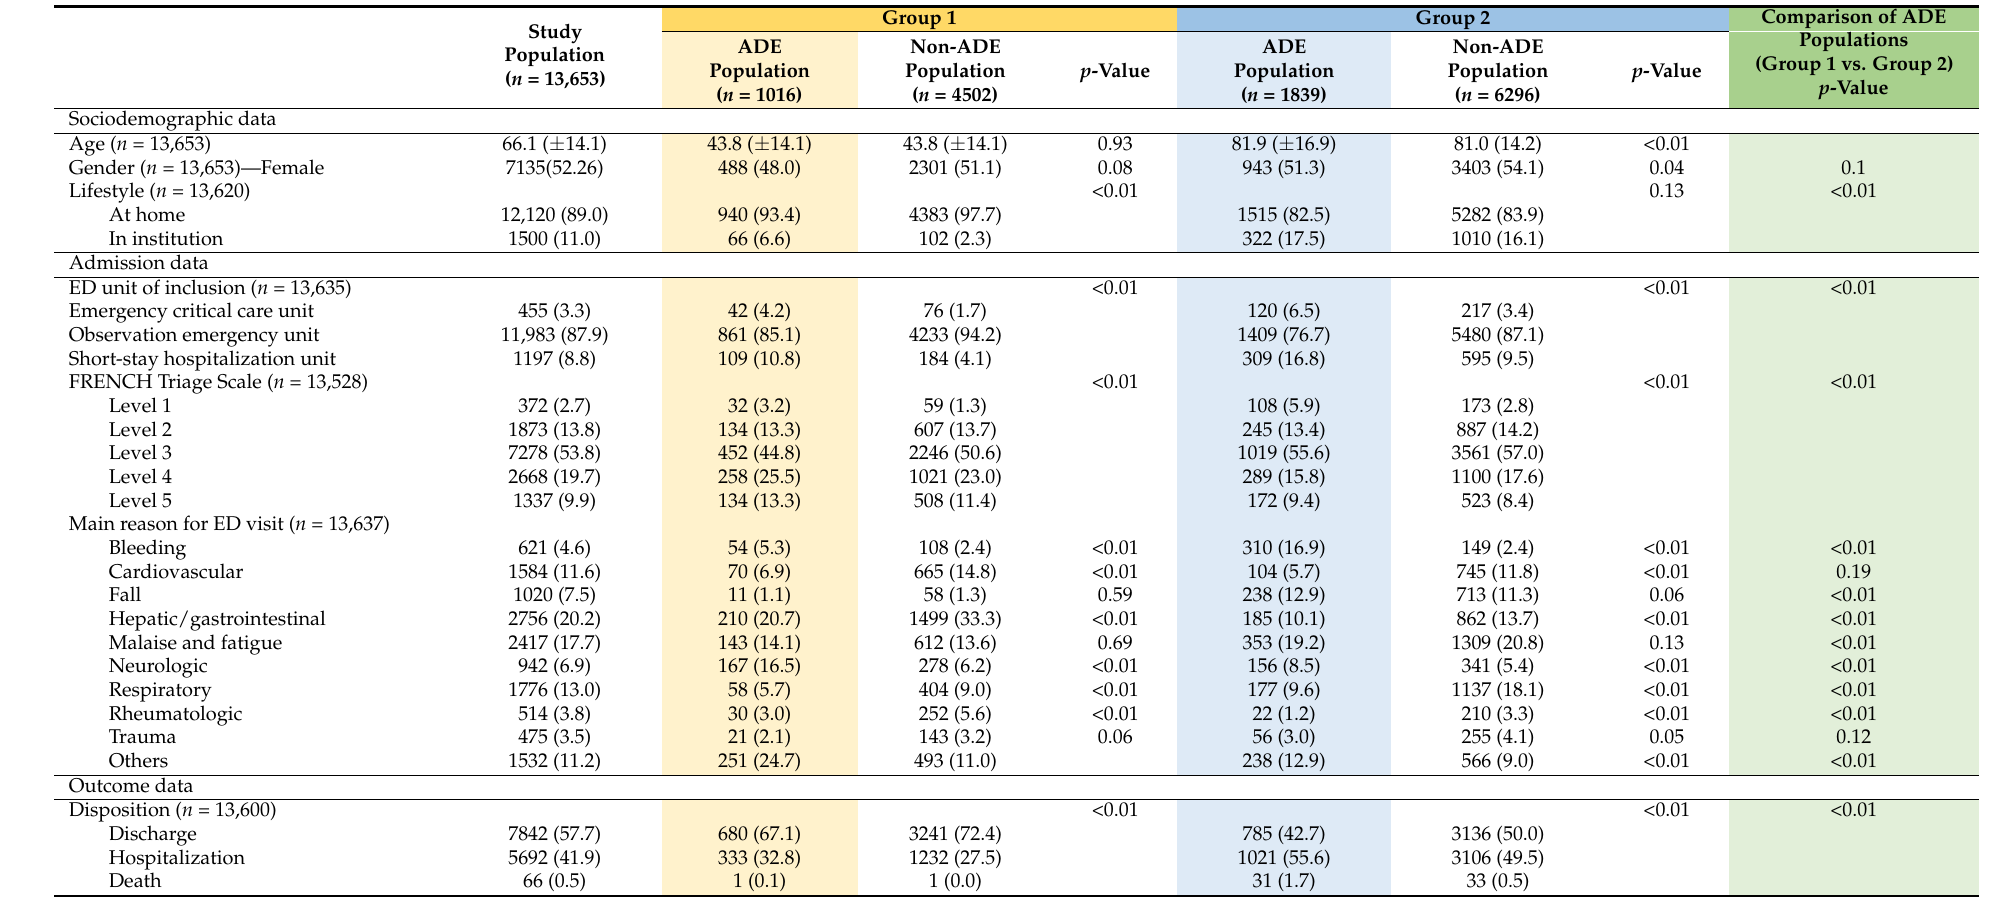
Table 1. Characteristics of the population by age group and presence/absence of an